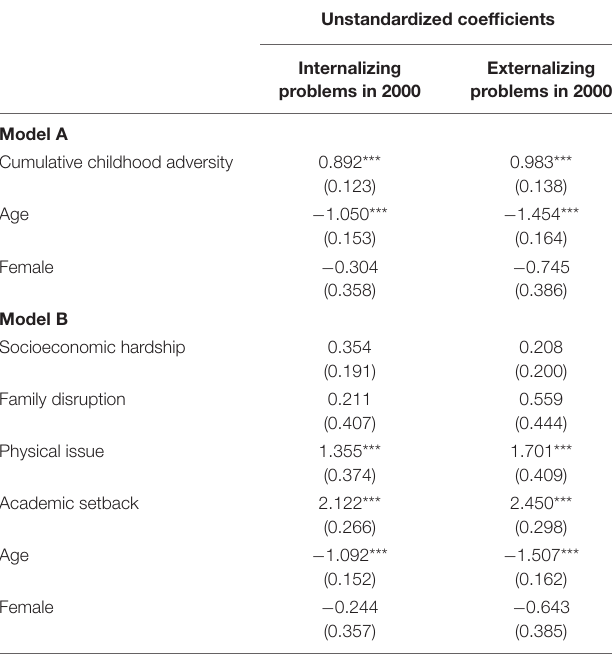
TABLE 2 | Maximum likelihood estimates of the associations between cumulative childhood adversity and mental health in